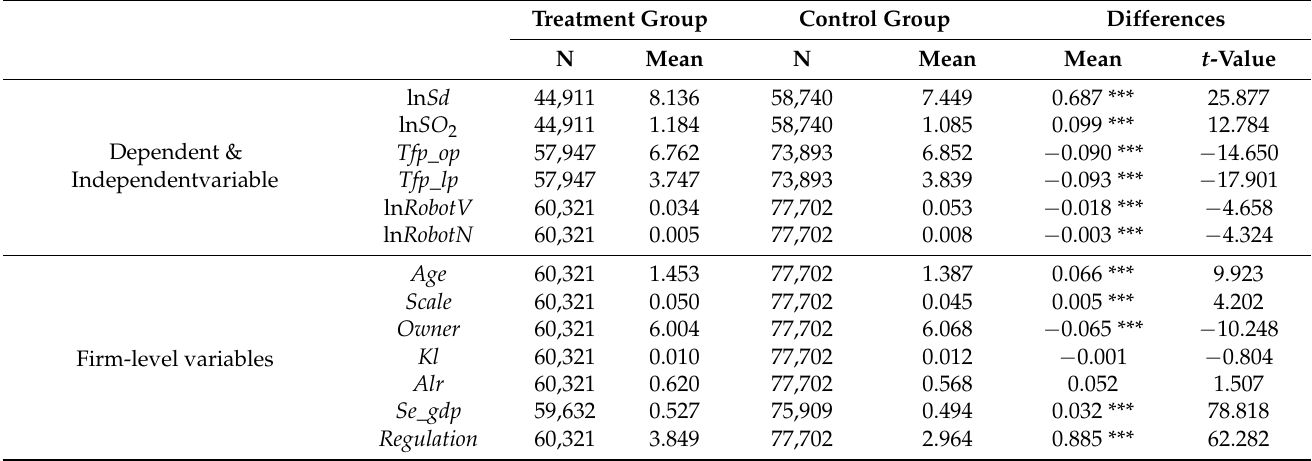
Table 3. Comparison between the treatment and the control